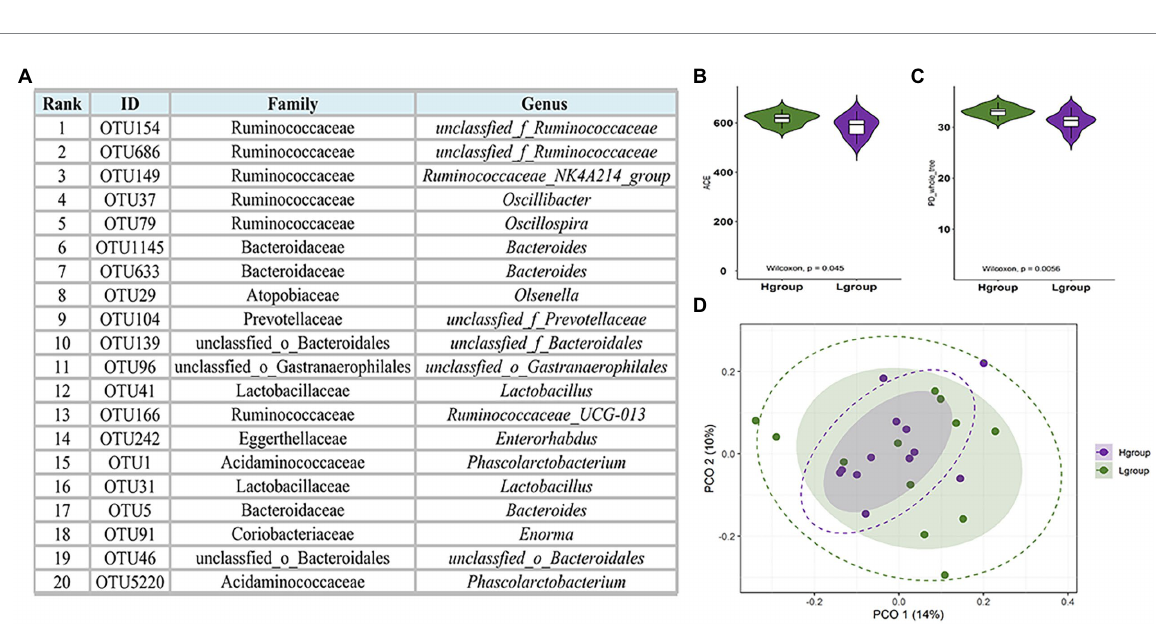
FIGURE 2 Hub cecal microbiota of Qiandongnan Xiaoxiang chickens at 160 ± 3 days of age and the difference of α -and β -diversity between chickens in high- (H group, n = 12) and low-market-weight (L group, n = 12) groups. (A) The 20 most abundant OTUs in the cecal microbiota network ranked using the Matthews Correlation Coefficient (MCC) method. Comparisons of (B) ACE and (C) PD indices between high-and low-market-weight chickens. (D) Principal coordinates analysis (PCoA) of microbial communities in cecal content samples based on unweighted UniFrac distances between high-and low-market-weight